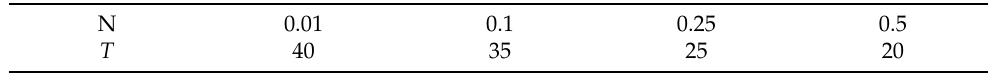
Table 1. Threshold value T chosen for noise intensities